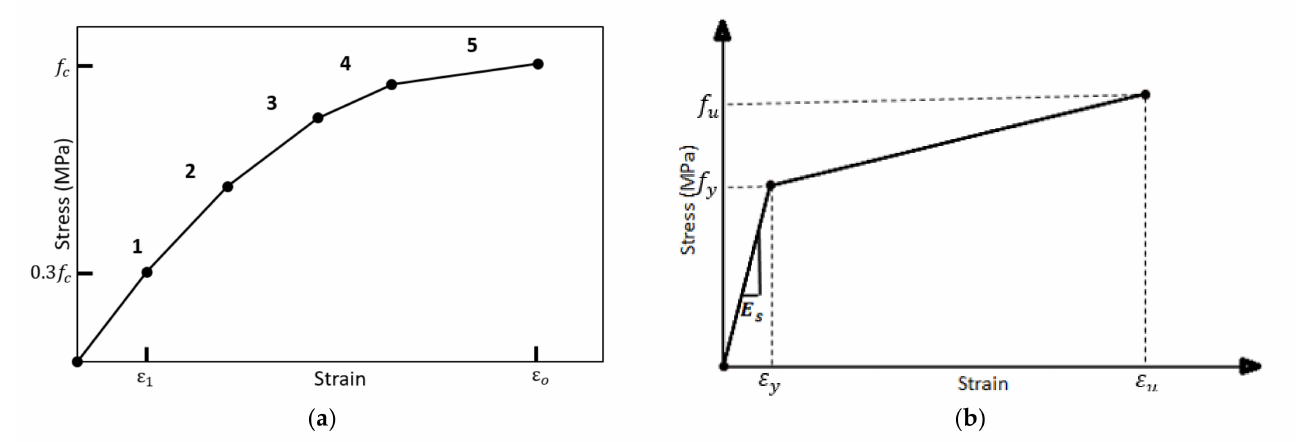
Figure 2. The stress-strain relationships adopted in the FE models. ( a ) For concrete. ( b ) For steel